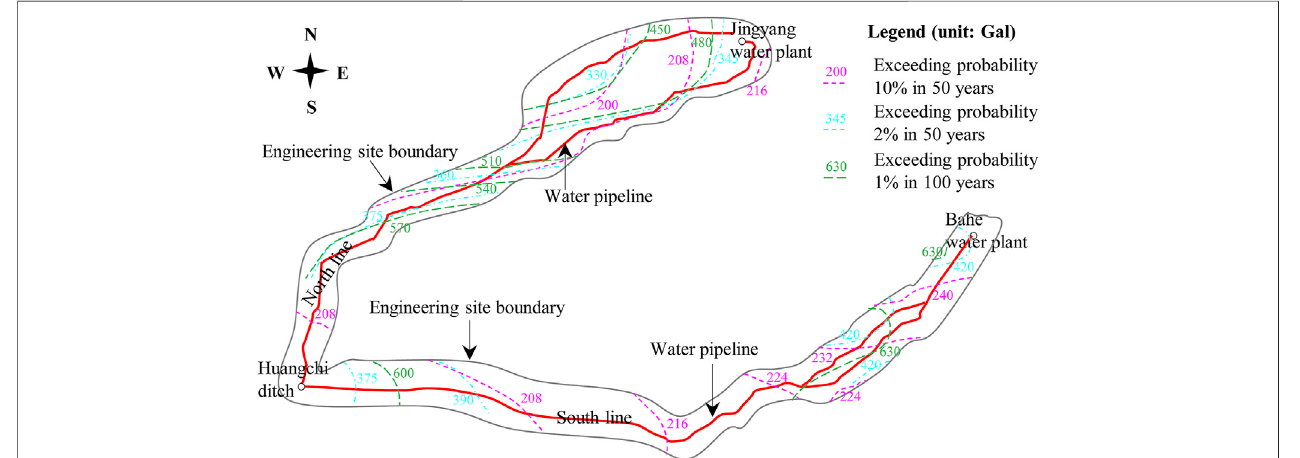
FIGURE 2 | Distribution of peak ground acceleration for typical exceeding probabilities (Deng,